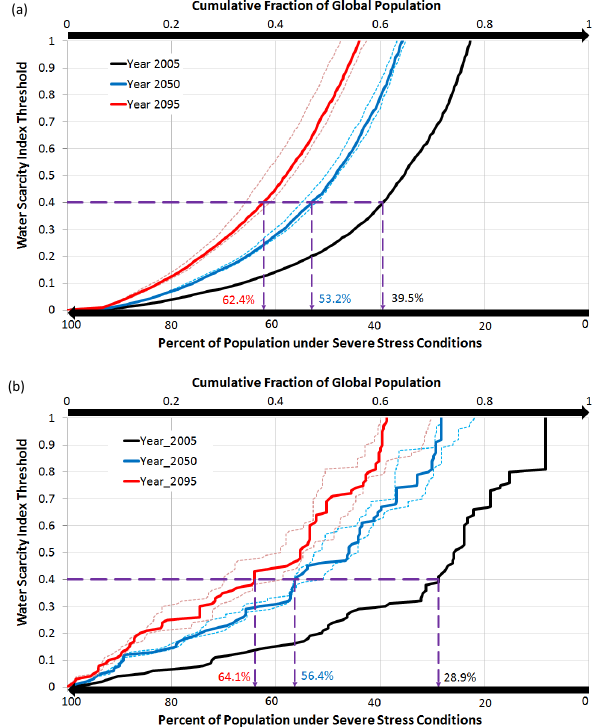
Figure 14: Shifts to the cumulative probability density function of the fraction of global population living under different levels of scarcity (WSI); water scarcity is estimated at the grid (a) and basin (b) scales; the thin lines reflect the uncertainty corresponding to the any one of the four GCMs instead of the ensemble mean; global populations living under severe water stress conditions increase from 40% (29%) in year 2005 to 53% (56%) and 62% (64%) in years 2050, and 2095, respectively